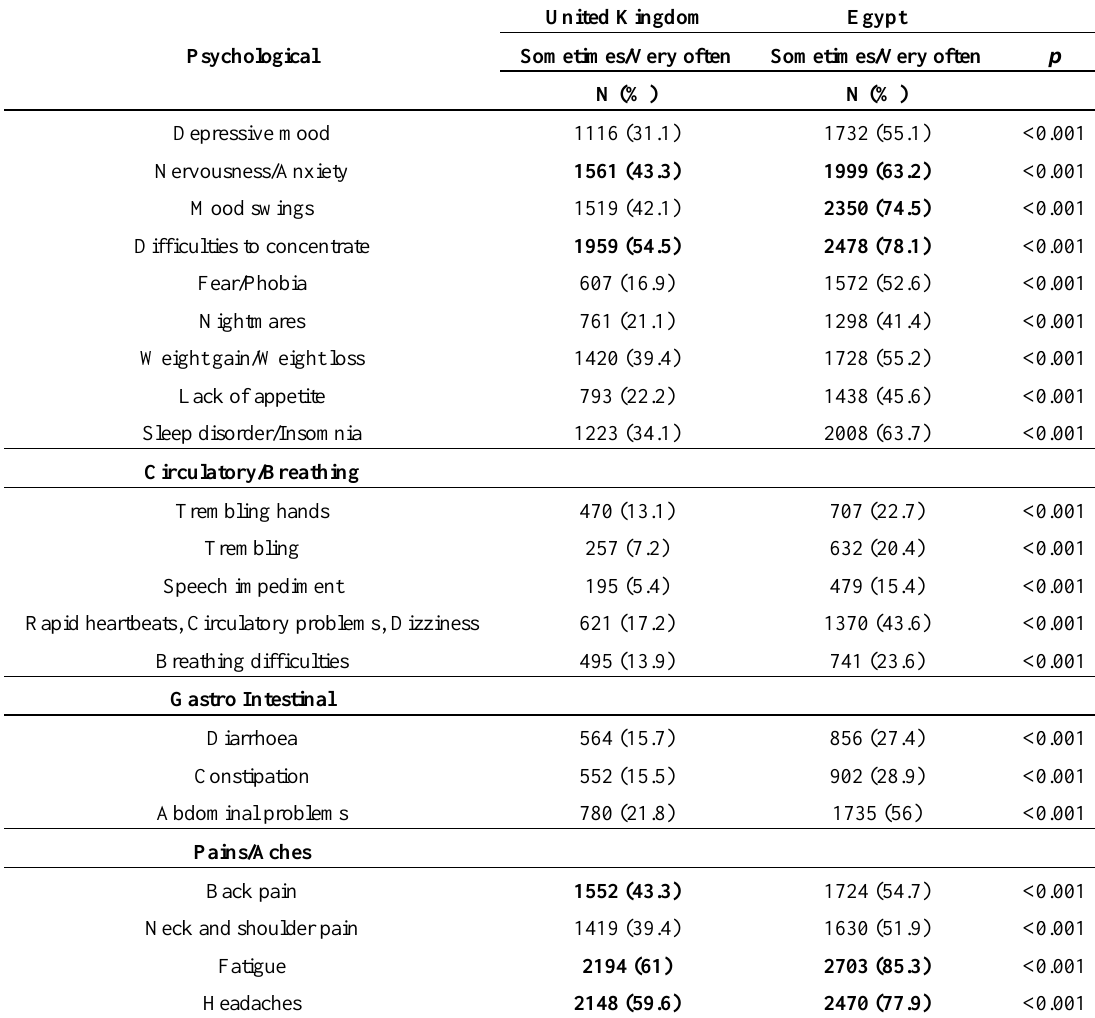
All percentages are row percentages for each country rounded to one decimal point; Bolded cells indicate some of the higher frequency symptoms/health complaints during last 12